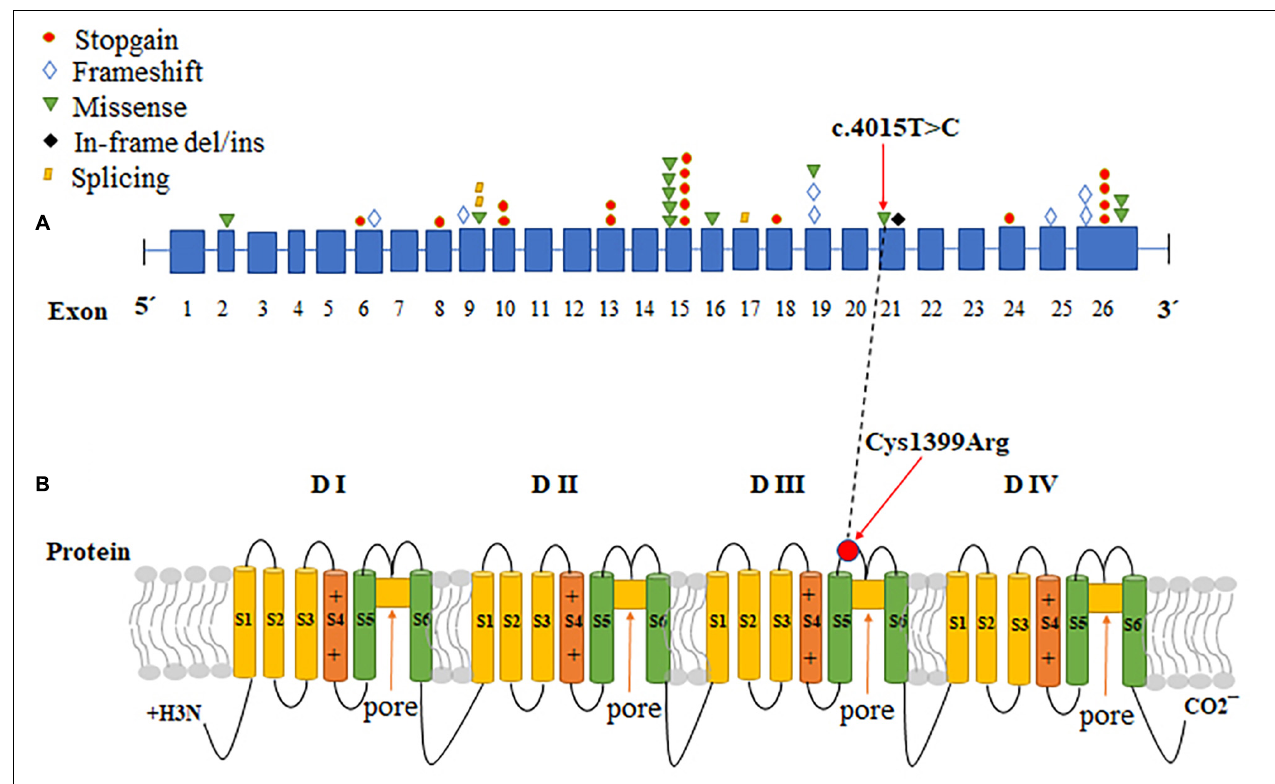
FIGURE 2 | The CDS sequence and protein structure pattern of SCN9A . (A) A variety of mutations in different exons in SCN9A cause CIP. The red circles: stopgain; blue diamonds: frameshift; green inverted triangles: missense; black diamonds: in-frame del/ins; yellow parallelograms: splicing. (B) Schematic representation of Nav1.7, the voltage-gated sodium channel (VGSC) a-subunit encoded by SCN9A , and the locations of the identified mutation. SCN9A encodes a plasma membrane protein, Nav1.7, which consisted of four similar domains with each domain comprising six a-helical transmembrane segments (labeled 1–6). Transmembrane segments 5 and 6 are the pore-lining segments and the voltage sensor is located in transmembrane segment 4 of each domain (depicted by a plus symbol). The red arrows indicate the location of the missense mutation identified in this study. The black dotted line correlates the change of CDS with protein change in